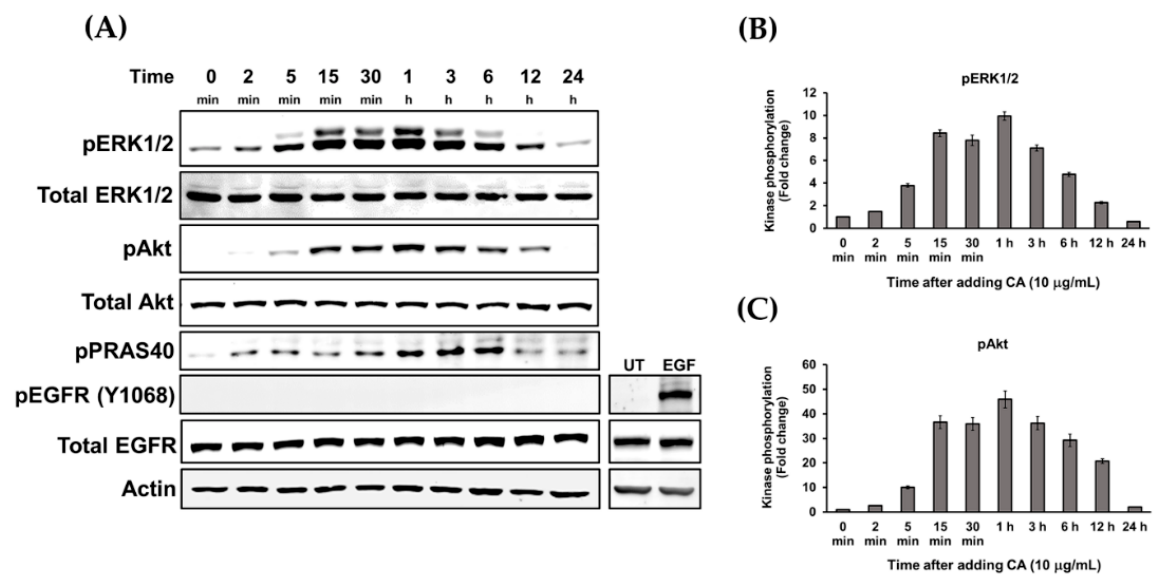
Figure 6. CA extract strongly stimulated ERK1/2 and Akt phosphorylation. ( A ) Time-dependent detection by Western blot analysis for the expression and phosphorylation of crucial signaling molecules (ERK1/2, Akt, PRAS40, and EGFR) in HaCaT cells treated with 10 µg/mL of CA extract over 24 h. ( B ) Quantification of the phosphorylation of ERK1/2 in CA extract-incubated HaCaT cells. ( C ) Quantification of the phosphorylation of Akt in CA extract-treated HaCaT cells. Actin was used as a loading control. Data from three individual experiments present mean ± SD; * p < 0.05.